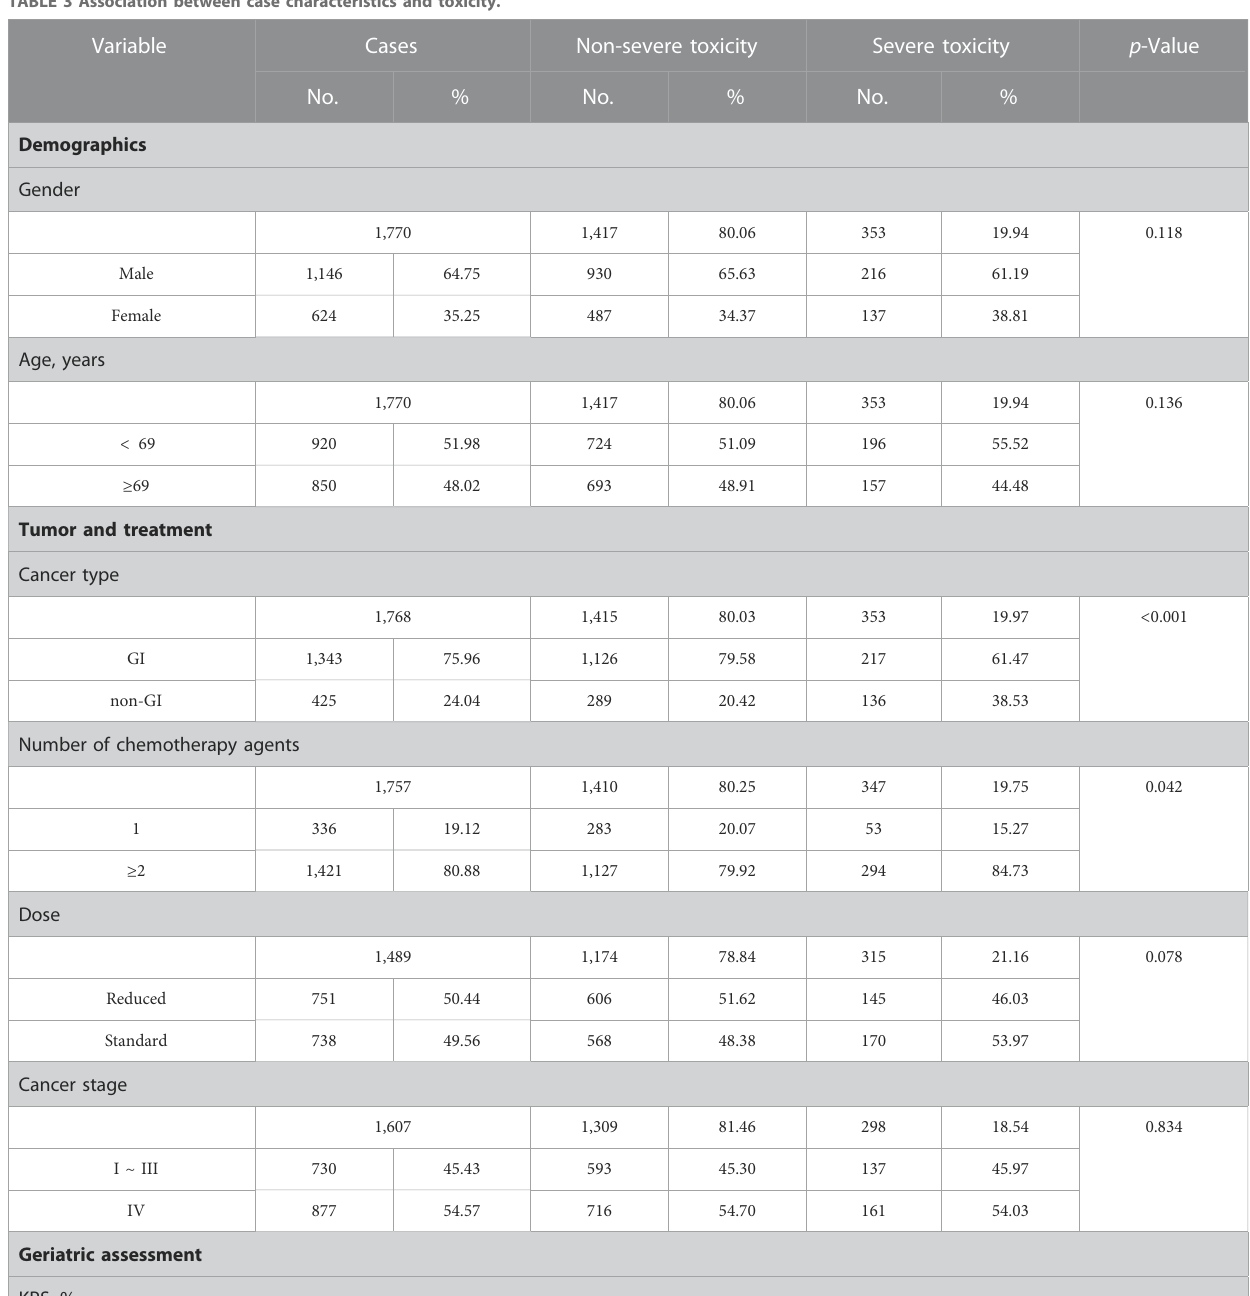
TABLE 3 Association between case characteristics and